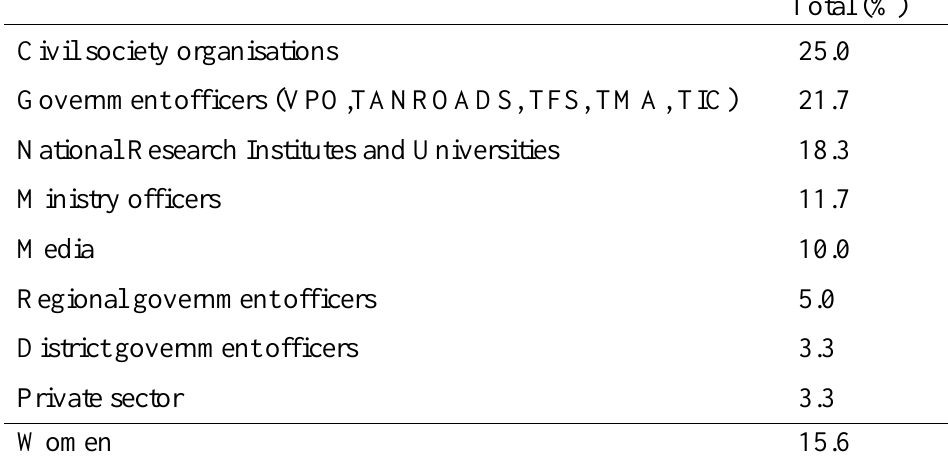
Table A1.2. Stakeholders’ composition in national workshops in